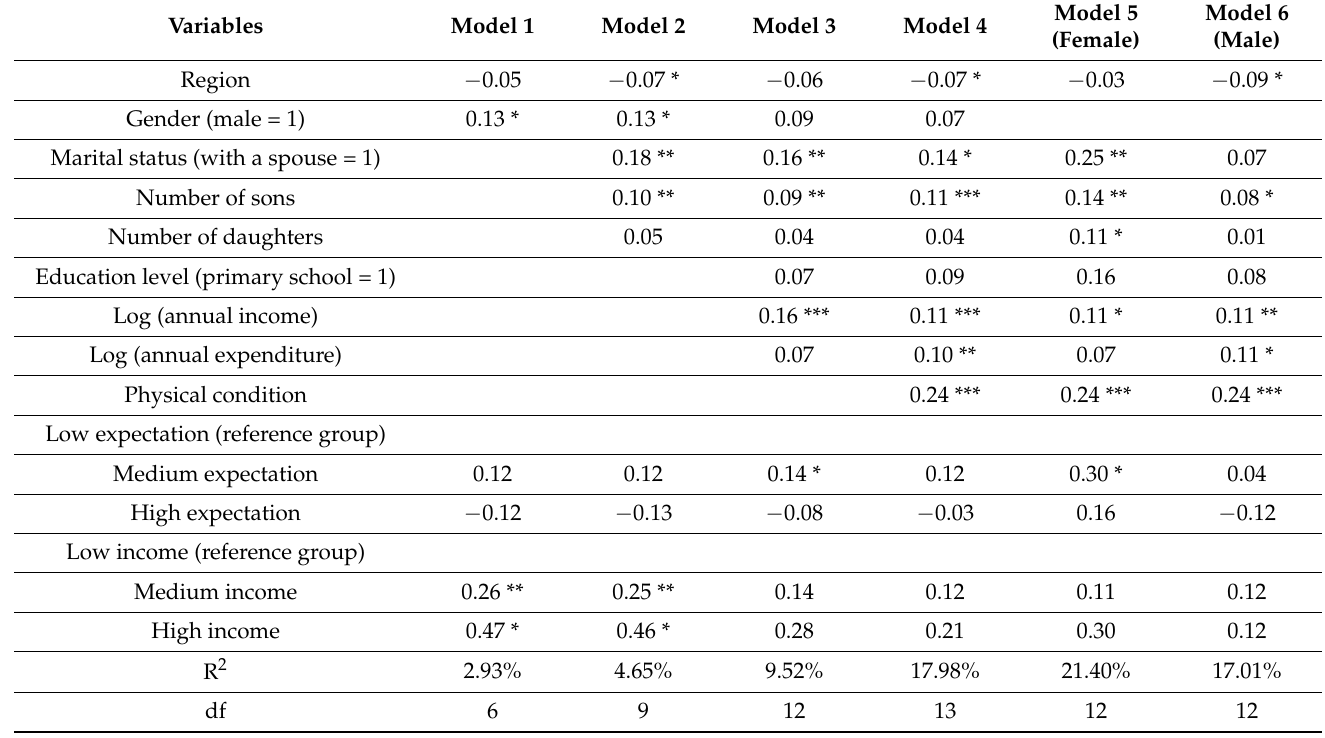
Table 4. Relationship between filial piety expectation level, filial piety income level, and life satisfaction.